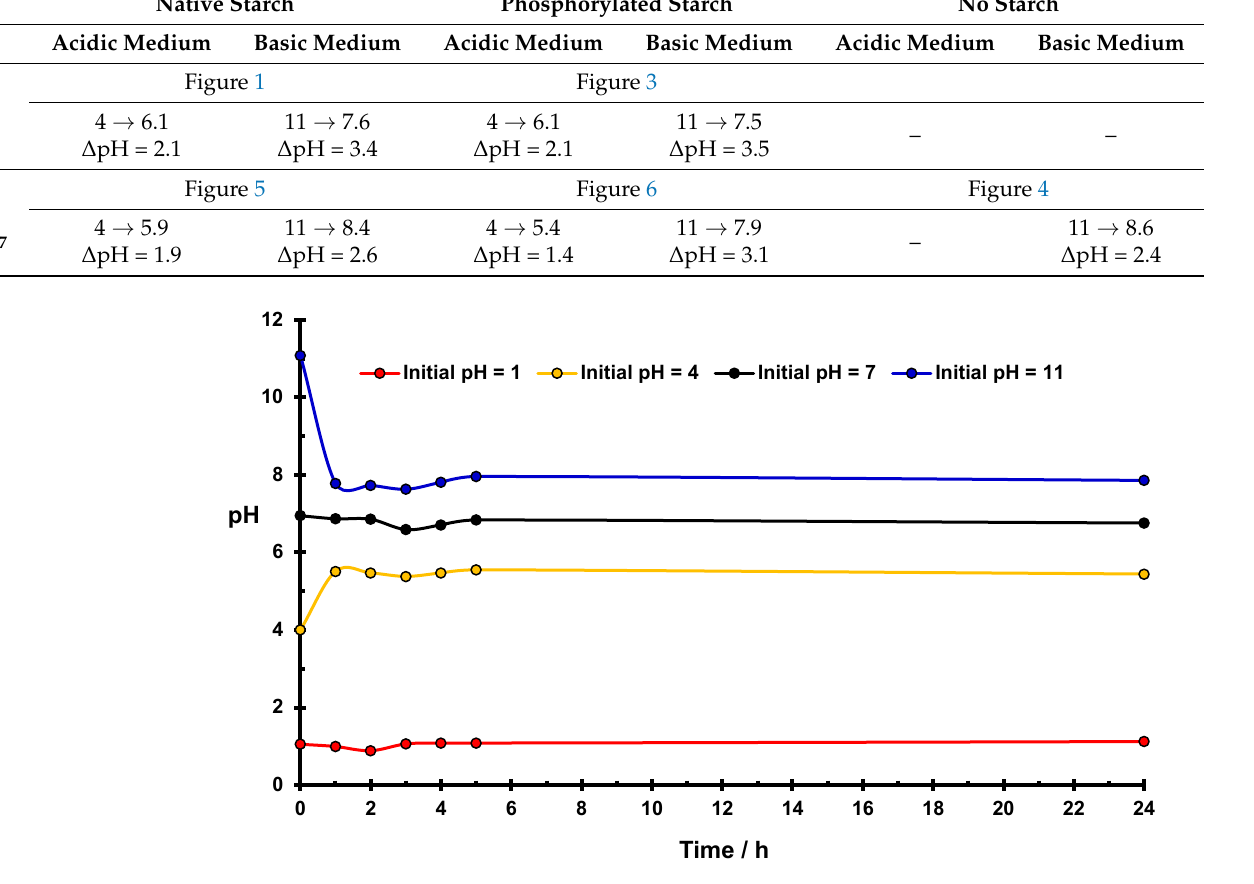
Figure 6. Changes in pH for the phosphorylated starch suspension in water solution of K 2 Cr 2 O 7 . Conditions: concentration of Cr(VI) = 1 g/L, 1 g of starch, 22.5 cm 3 of a solution, room temperature.